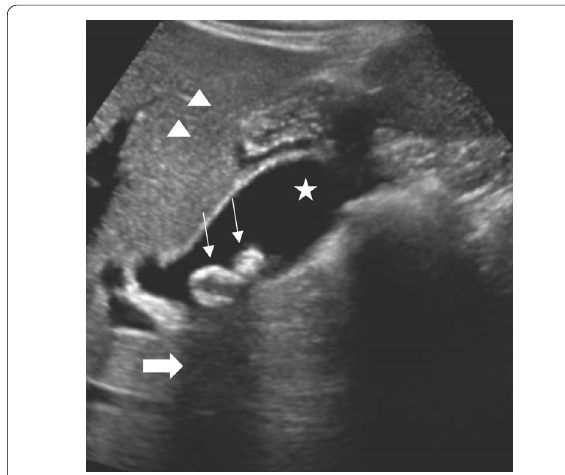
Fig. 2 Gall bladder calculi: Gall bladder calculi appears as a highly reflective echogenic focus (long thin arrows) within gallbladder lumen (star), with prominent posterior acoustic shadowing (thick arrows). The liver parenchyma (arrowheads) can be seen on the superior aspect of the acoustic window